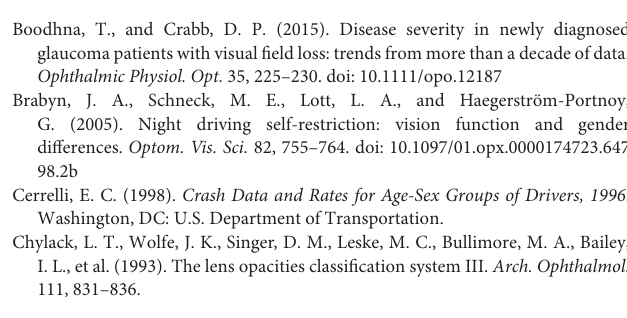
Supplementary Figure 1 | CS measurements for the four conditions assessed in the driving simulator, shown for individual participants. The same data are expressed as group averaged in Figure 5 of the main